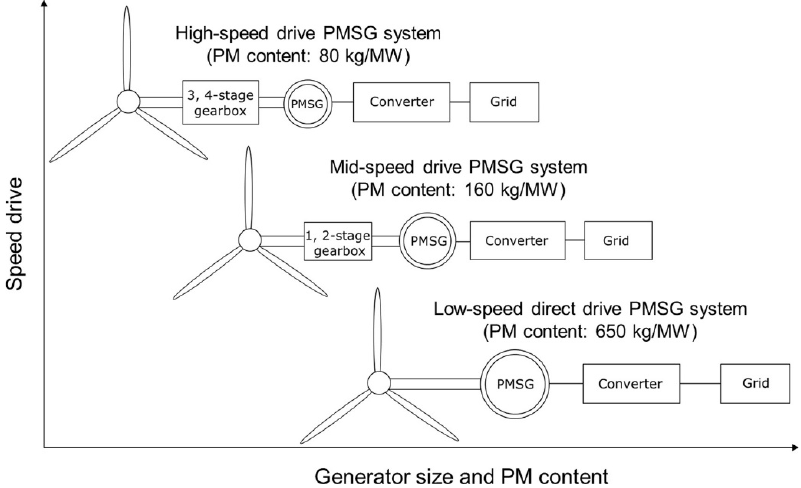
Figure 2. Influence of wind turbine drivetrains on PMSG and gearbox sizes.